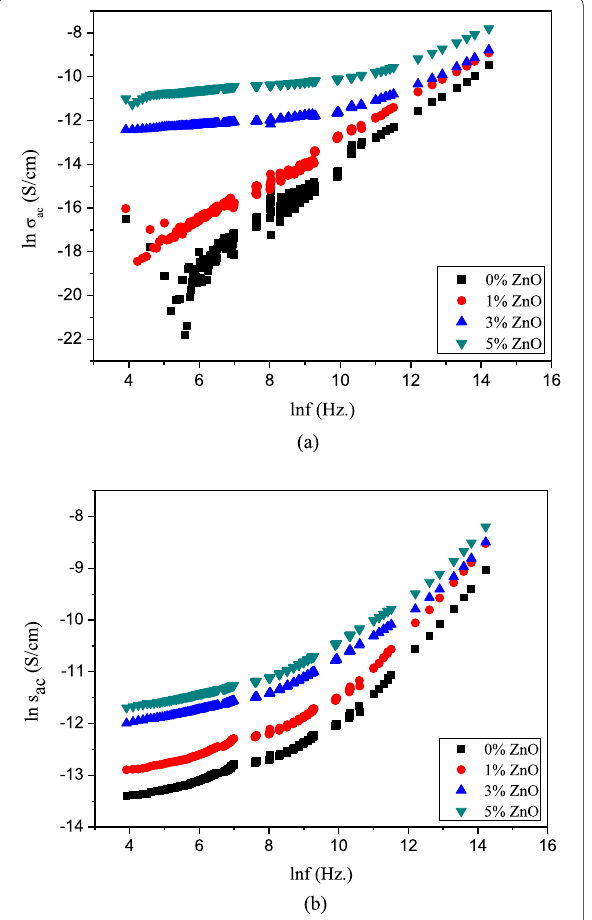
Fig. 5 Frequency dependence of alternating current (AC) conductivity for zinc oxide (ZnO) nanoparticle‑filled (i.e., 0, 1, 3, and5%) cross‑linked polyethylene at 0 kGy ( a ) and 25 kGy ( b ). The AC conductivity increases as the frequency increases due to the effects of the electron beam dose (25 kGy)